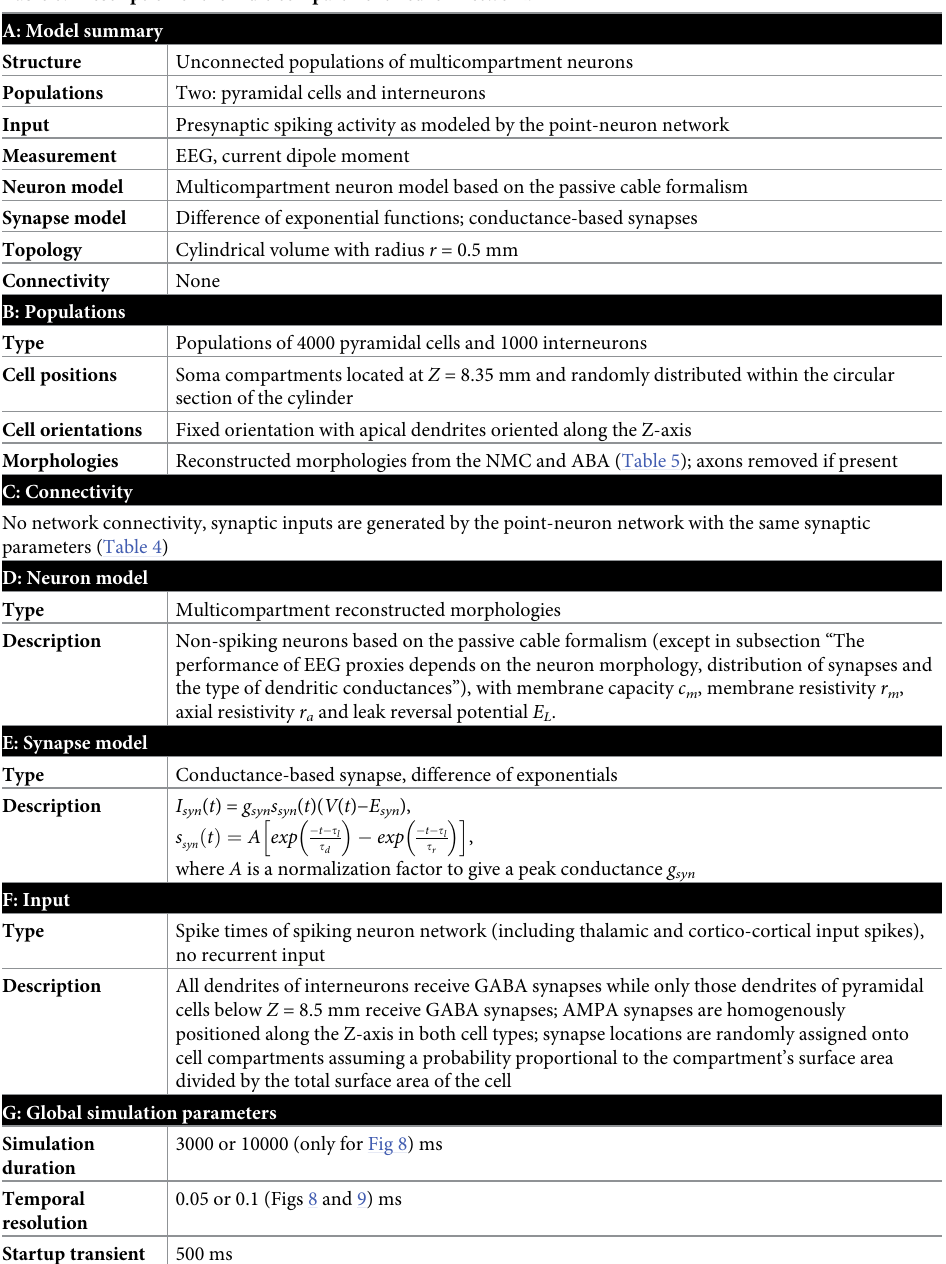
Table 6. Description of the multicompartment neuron